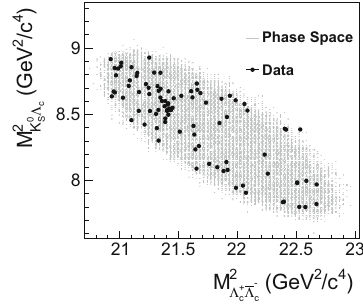
¯ (cid:4) − (cid:4) + c c candi- S